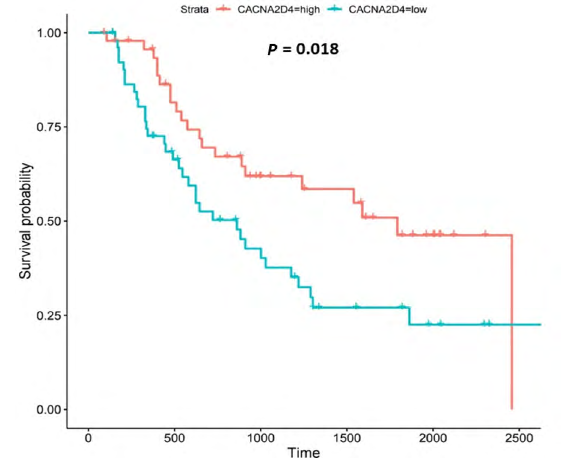
Figure 8. Kaplan-Meier survival plot for CACNA2D4 . Details as described in Figure 6